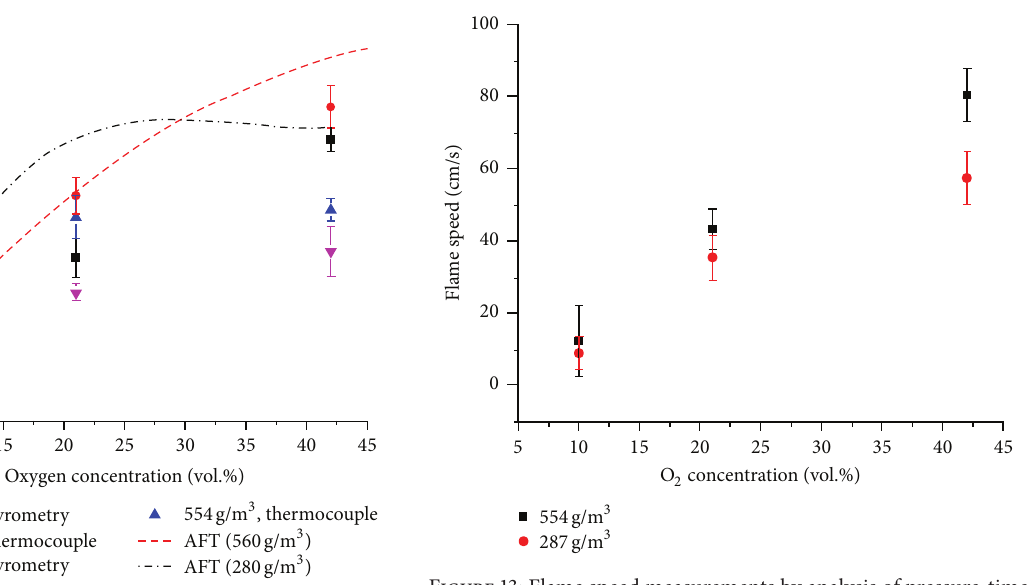
Figure 12: Temperature measurements of sulfur dust explosions.